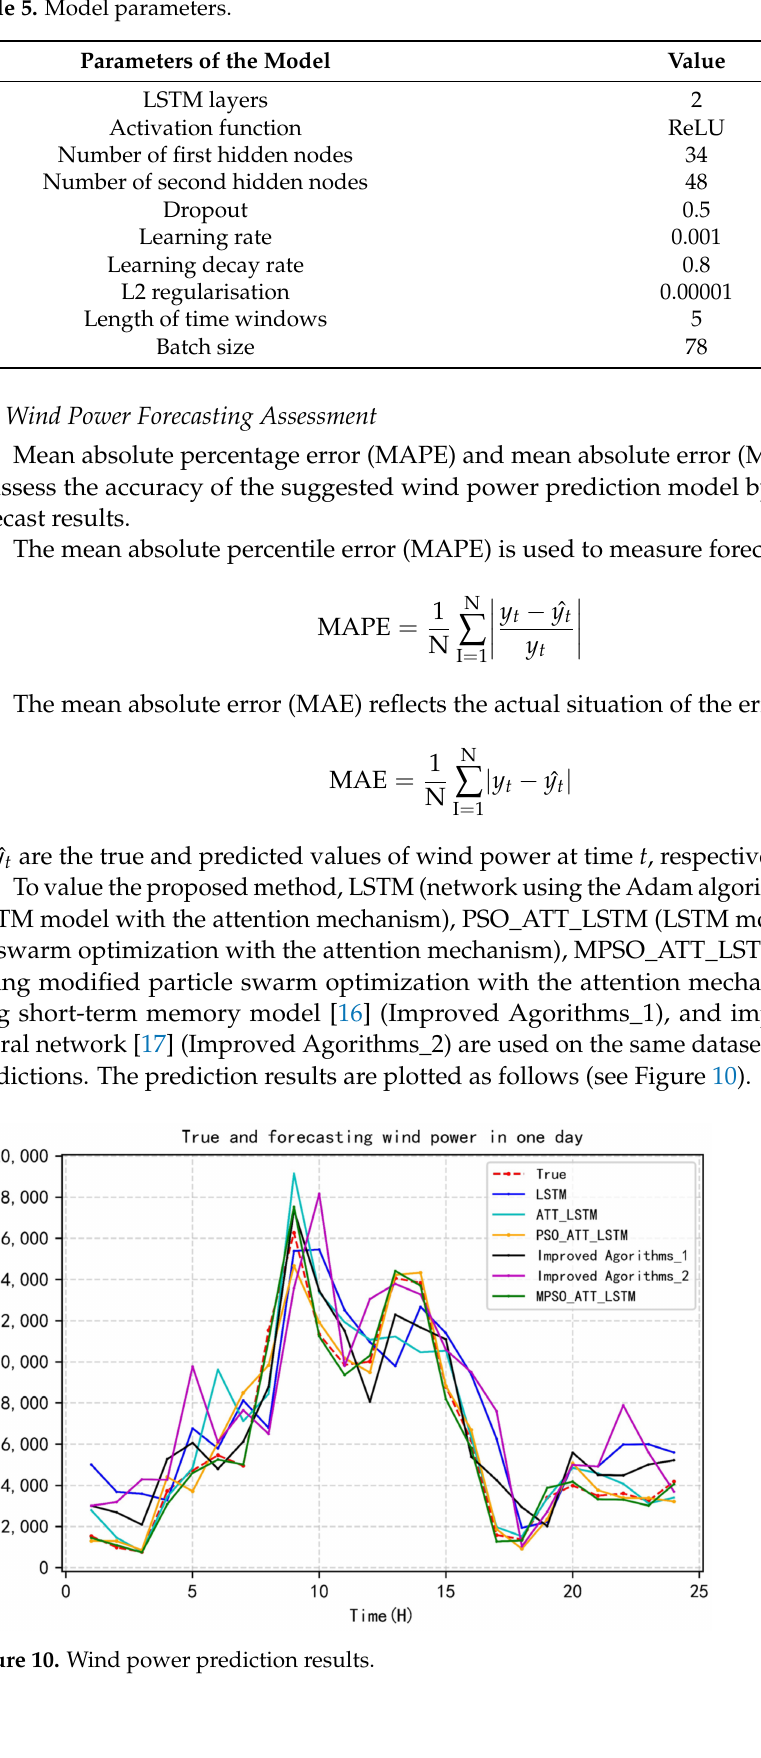
Table 5. Model parameters.